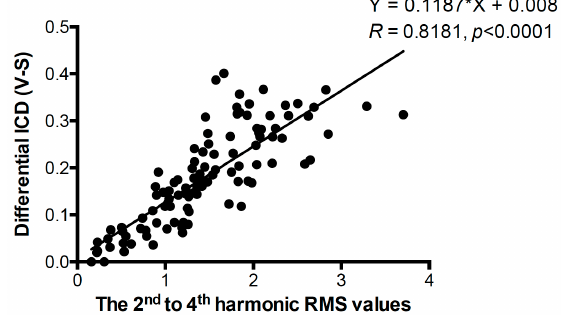
Figure 7. Correlation of differential ICD values versus the 2 nd to 4 th harmonic RMS values. The correlation coefficient ( R ), the p -value of the Pearson’s correlation test, and the equation of the linear regression line are shown around the line. n = 105.